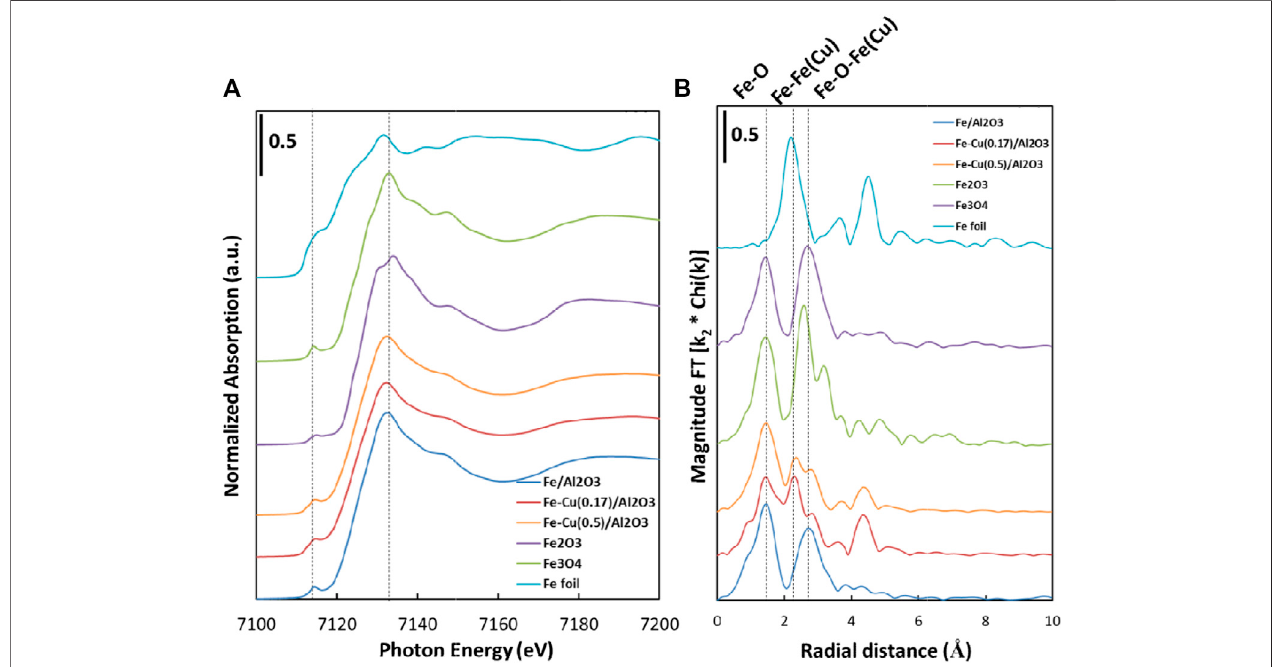
FIGURE 4 | TEM images of the reduced Fe-Cu(0.17)/Al 2 O 3 with different magni fi cations (A – C) and its particle size distribution based on approximately 200 particles of TEM image (D) .